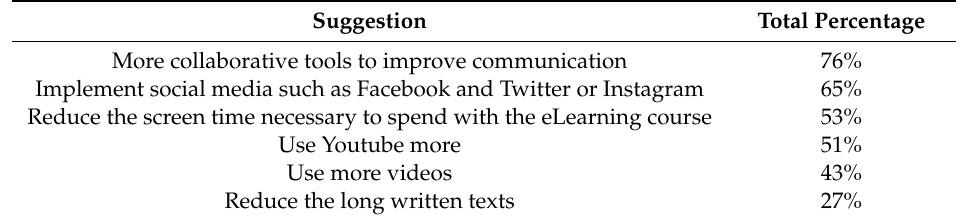
Table 3. Experimental group students´ suggestions regarding the improvement of the online